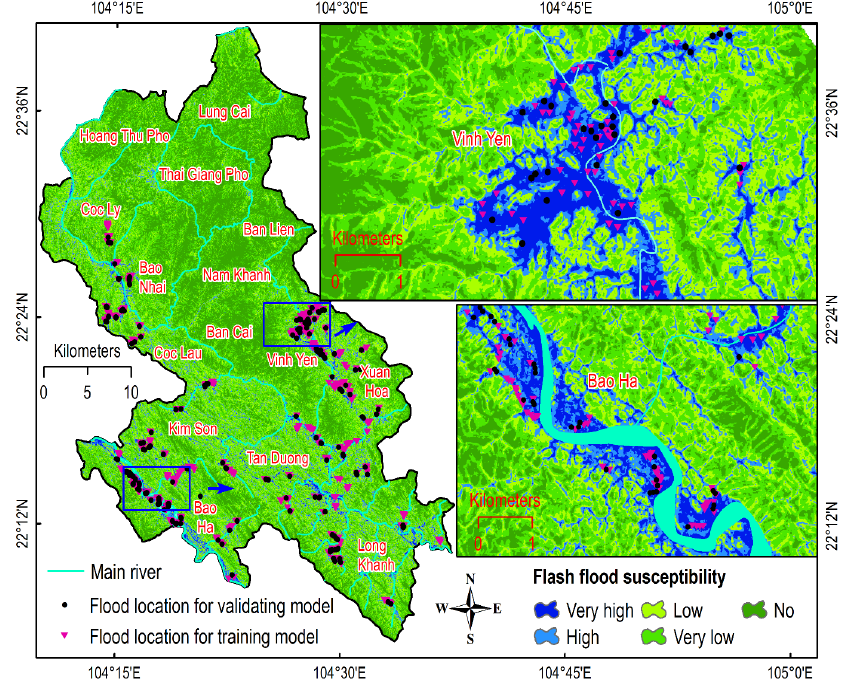
Figure 15. Flash flood susceptibility map for the study